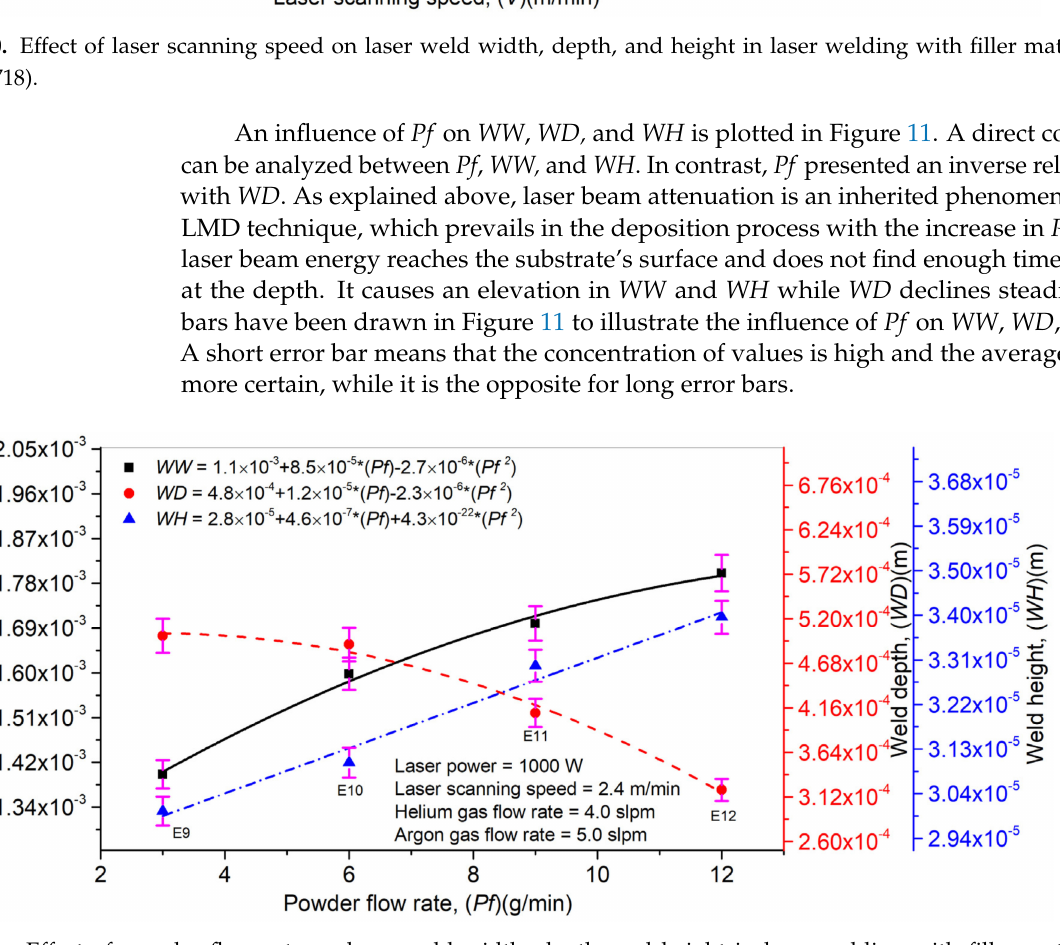
Figure 11. Effect of powder flow rate on laser weld width, depth, and height in laser welding with filler material (Inconel